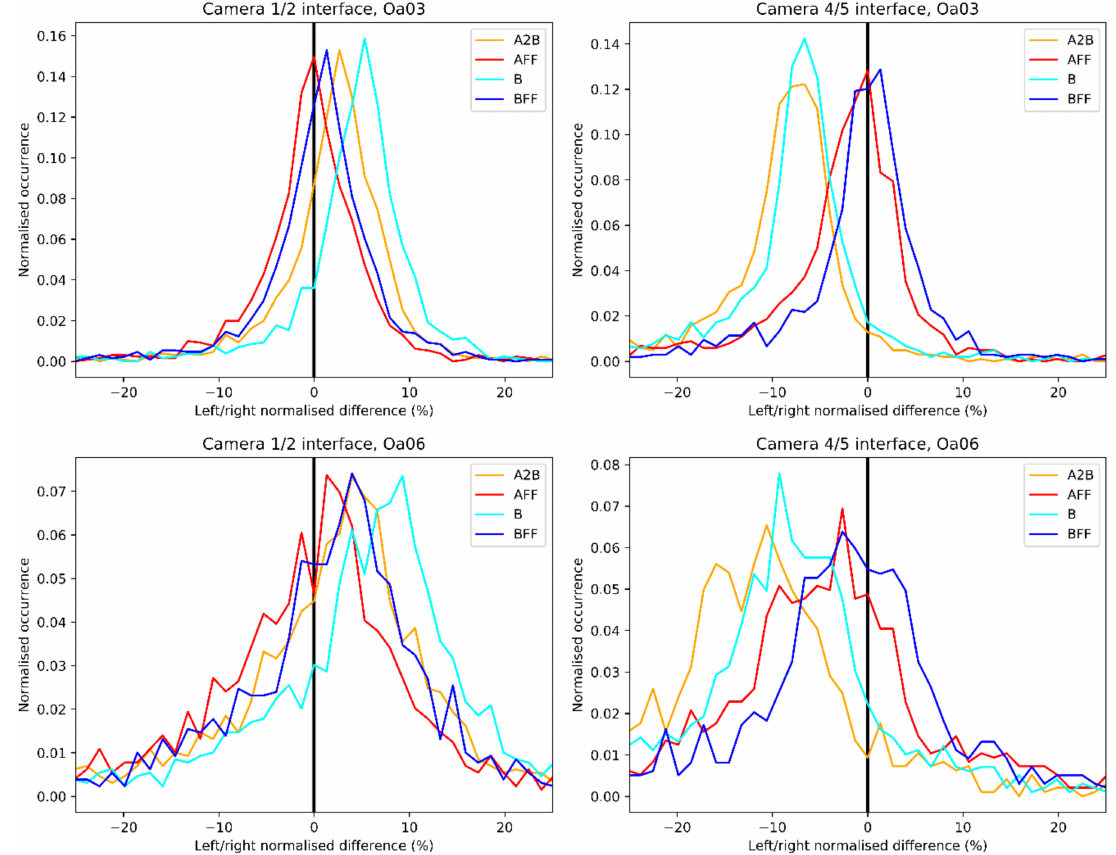
Figure 25. Water-leaving reflectance (Oa03, left ; Oa06 right ) normalised relative di ff erences between the values obtained from the two adjacent cameras of interface 1 / 2 ( left ) and interface 4 / 5 ( right ) for the four calibration setups. Inter-camera di ff erences are e ffi ciently reduced with flat-fielding.